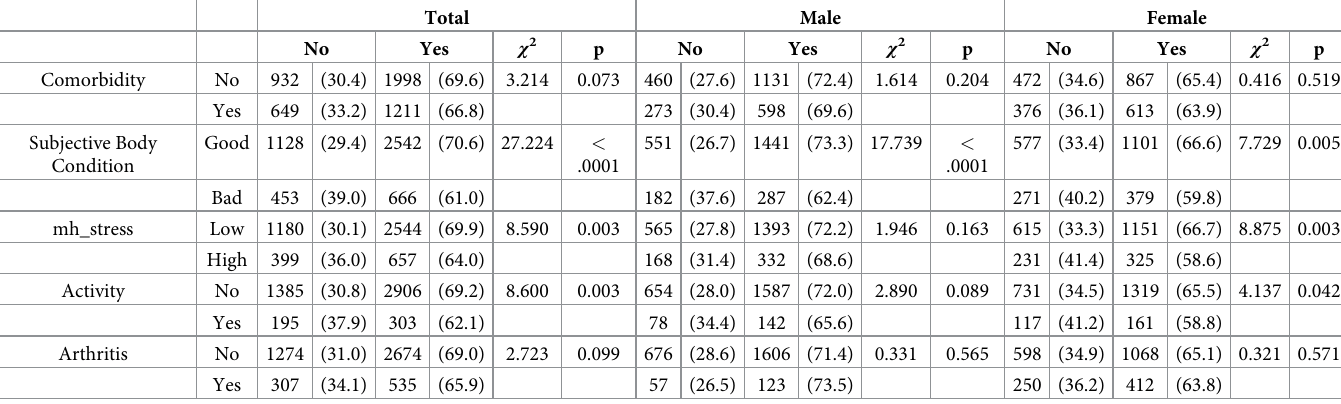
Table 4. Differences in regular workout habits based on physical